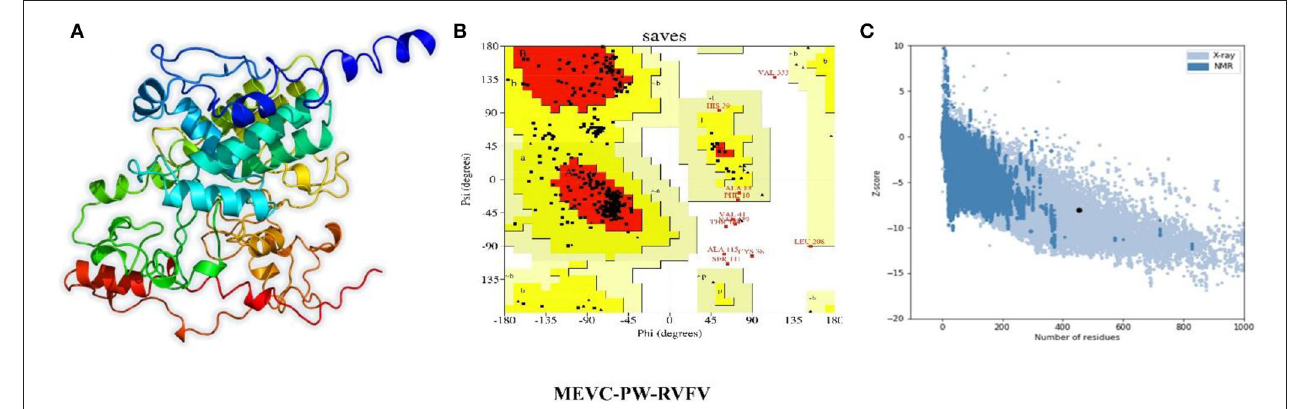
FIGURE 4 | Modeled 3D structures of MEVC designed against the whole proteome of RVFV. Here, (A) represents the 3D modeled structures of MEVCs, (B) represents the Ramachandran plot analysis, and (C) represents the ProSA-Web analysis of the 3D modeled